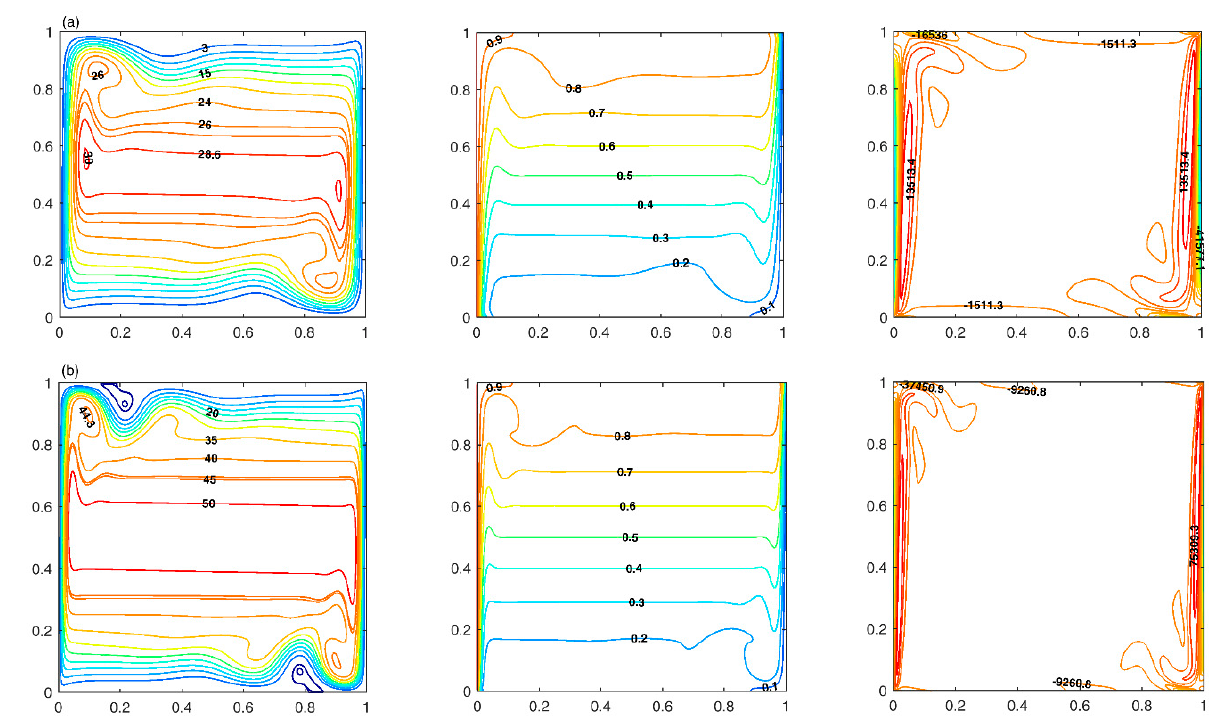
Figure 2. Streamlines ( left ), Temperature contours ( middle ), Vorticity contours ( right ) for ( a ) Ra = 10 7 and ( b ) Ra = 10 8 .